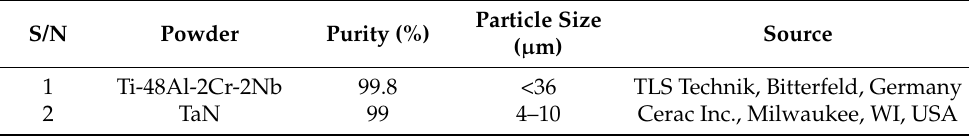
Particle Size Source ( µ m)